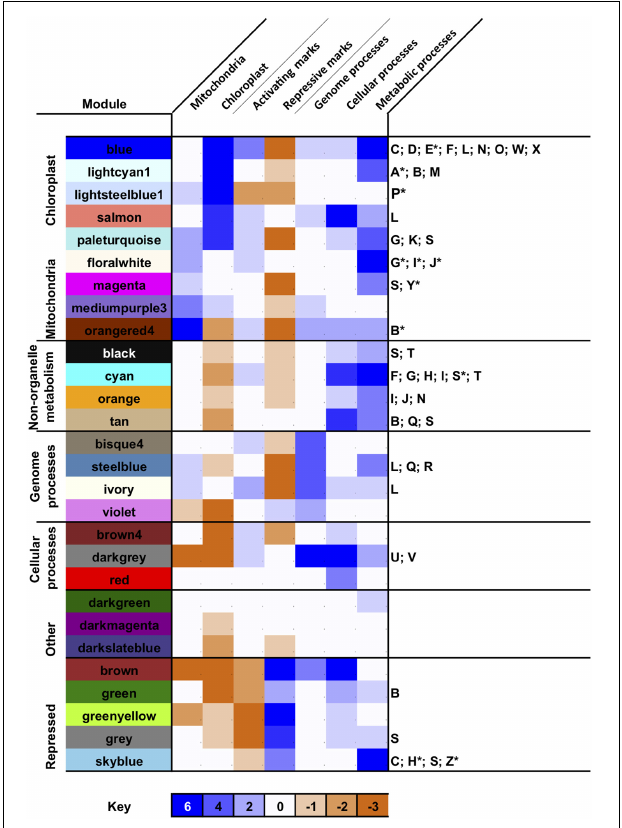
FIGURE 3 | Biological properties associated with PhaeoNet merged modules. This Figure provides an overview of enrichments of different organelle targeting (Horton et al., 2007; Gschloessl et al., 2008; Fukasawa et al., 2015; Gruber et al., 2015), epigenetic (Veluchamy et al., 2013, 2015; Zhao et al., 2020), evolutionary (Rastogi et al., 2018) and KEGG pathway annotations (Kanehisa, 2017) enriched in merged modules. The first seven (shaded) columns provide a score for different conditions, aggregated from chi-squared P-values of multiple enrichment predictors (defined beneath): enrichments in each condition carry a score of +1 if significant to P < 0.05 and +2 if significant to P < 10 − 05 ; and depletions in each condition carry a score of –1 if significant to P < 0.05 and –2 if significant to P < 10 − 05 , assessed by chi-squared test against a null hypothesis of a random distribution of these features across all genes assigned to a PhaeoNet merged module. The final column lists all metabolic pathways enriched to P < 0.05, or P < 10 − 05 (asterisked) for each merged module, assessed by chi-squared test as above. Verbose outputs for each set of conditions are provided in Supplementary Figure 5 . Additional annotations, e.g., enrichments in inferred evolutionary origins of each merged module, are provided for user exploration in Supplementary Table S2